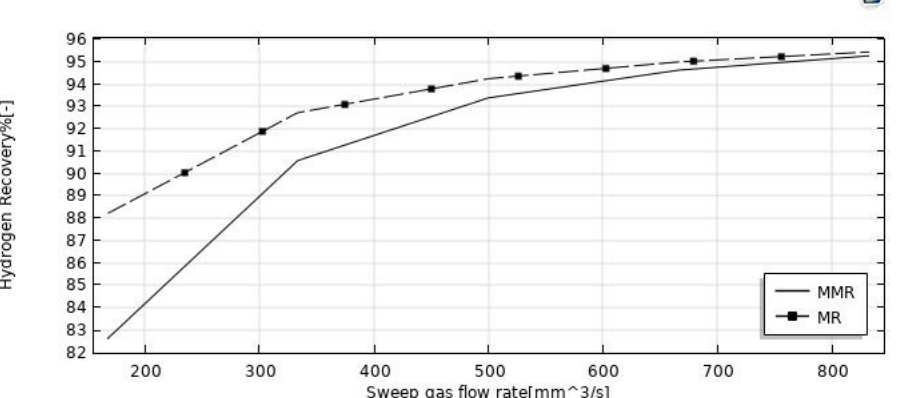
Figure 10. Effect of feed flow rate on the hydrogen recovery at p = 1 bar, T = 400 °C, and feed flow rate = 20 mm 3 /s.